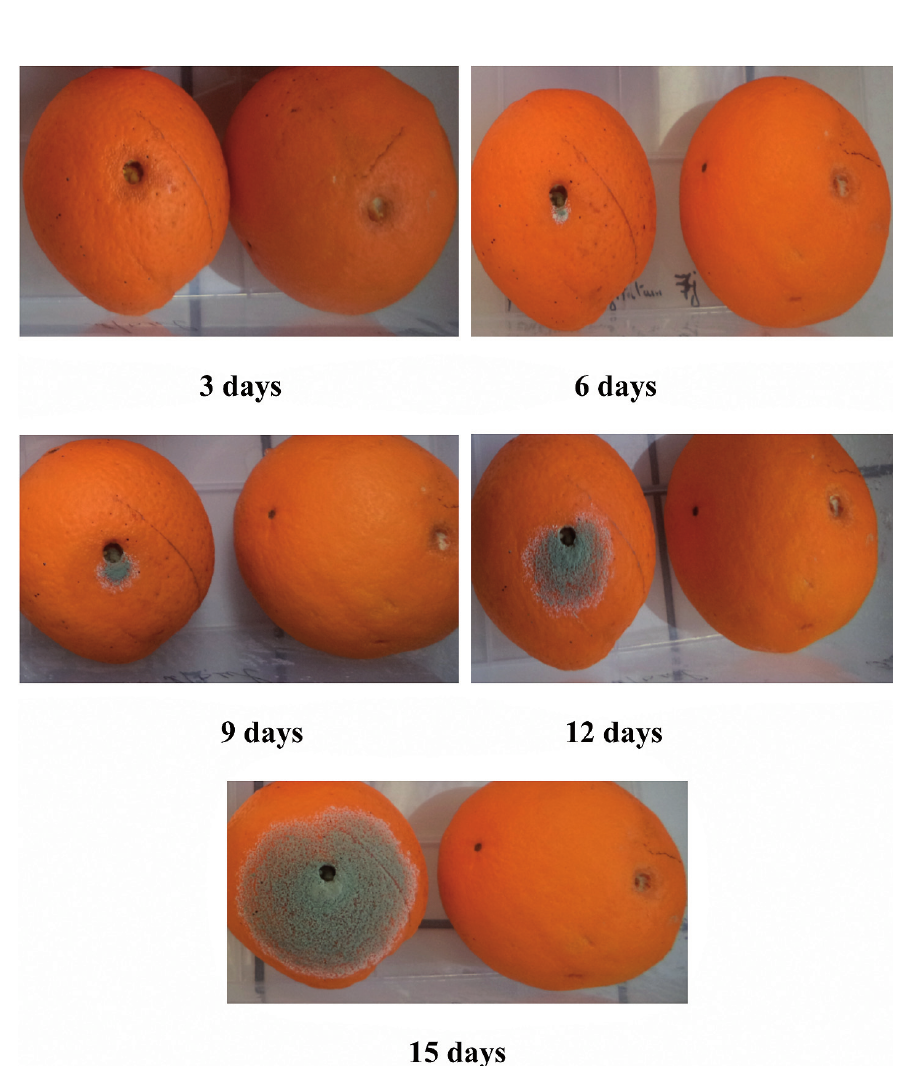
Fig 1: Decayed orange (left), inoculated with only pathogen P. italicum (positive control), and not decayed orange (right) onto which hydrosol (0.2 μg/mL) was applied 30 min before pathogen inoculation, kept at 25 °C for the period stated below the respective